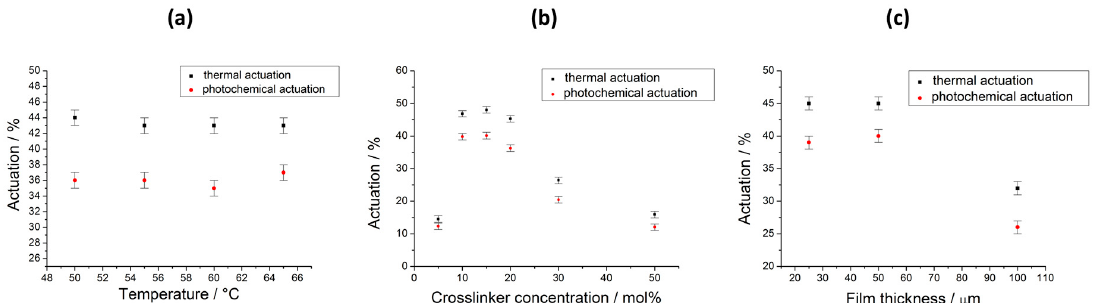
Figure 5. Photo- and thermal actuation of LCE films with variation of the synthesis parameters. ( a ) Influence of the polymerization temperature on the actuation for a film with 20 mol % crosslinker and a thickness of 50 µm; ( b ) influence of the crosslinker concentration (polymerization temperature: 60 °C, sample thickness: 50 µm), and ( c ) influence of the sample thickness (polymerization temperature: 60 °C, 10 mol % crosslinker concentration).